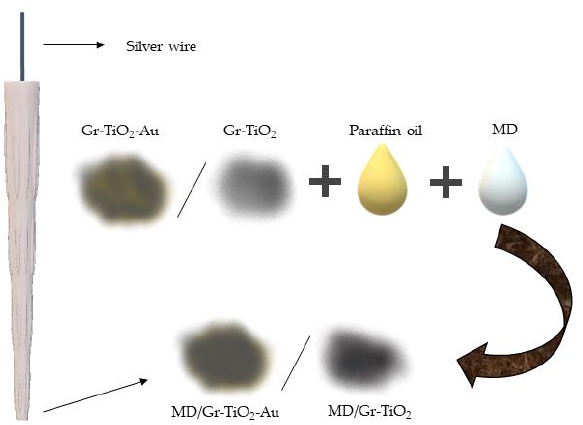
Scheme 1. Schematic representation of the design of the stochastic sensors.